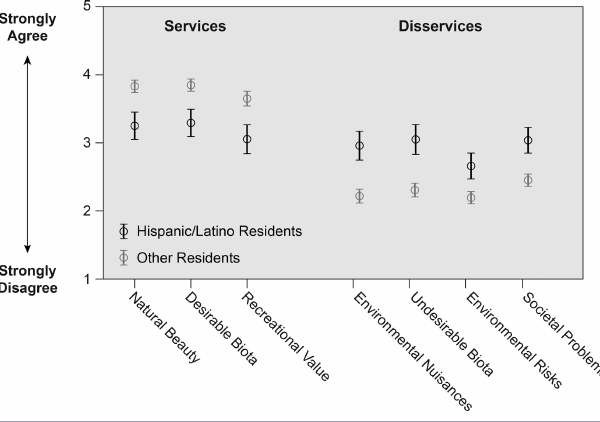
Fig. 2 . Ecosystem services (ES) and ecosystem disservices (EDS) scales: comparisons of Hispanic/Latino residents versus